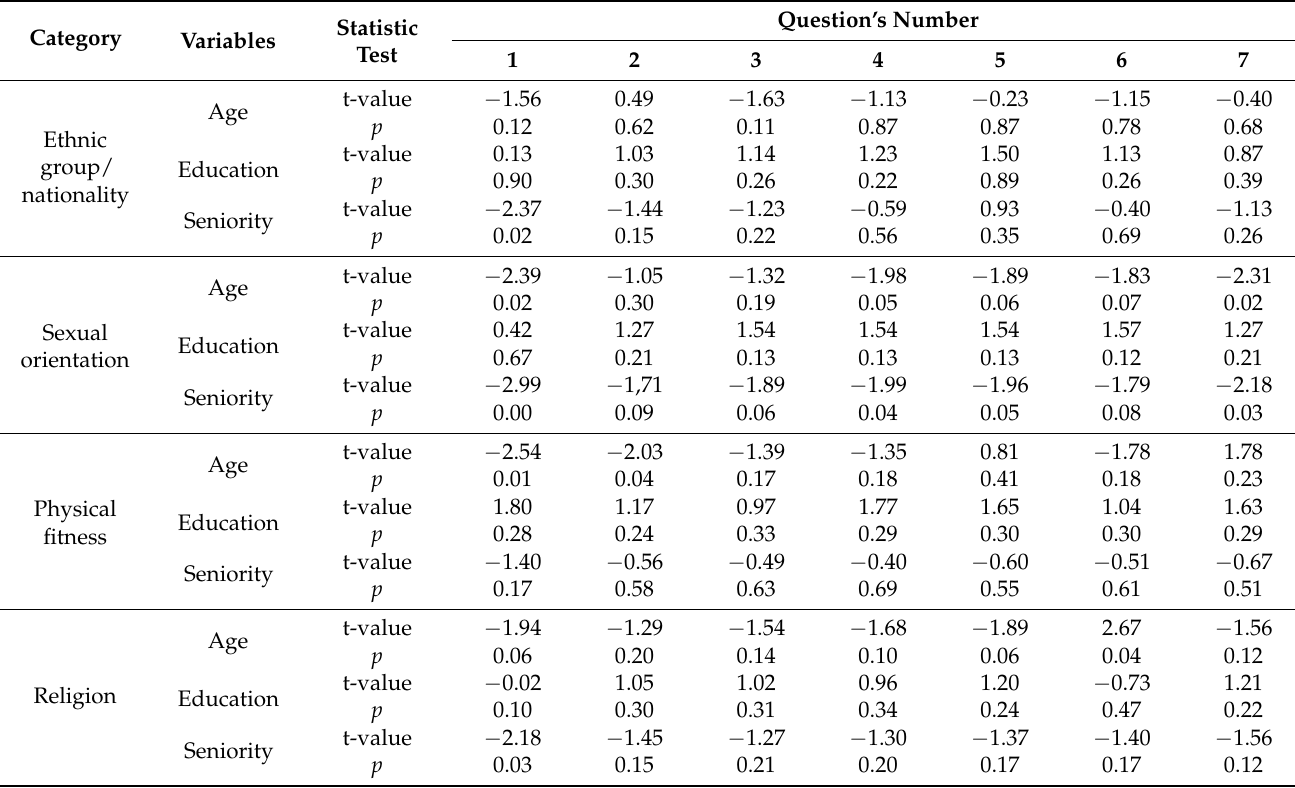
Table 4. Analysis of social group, type of question and sociometric